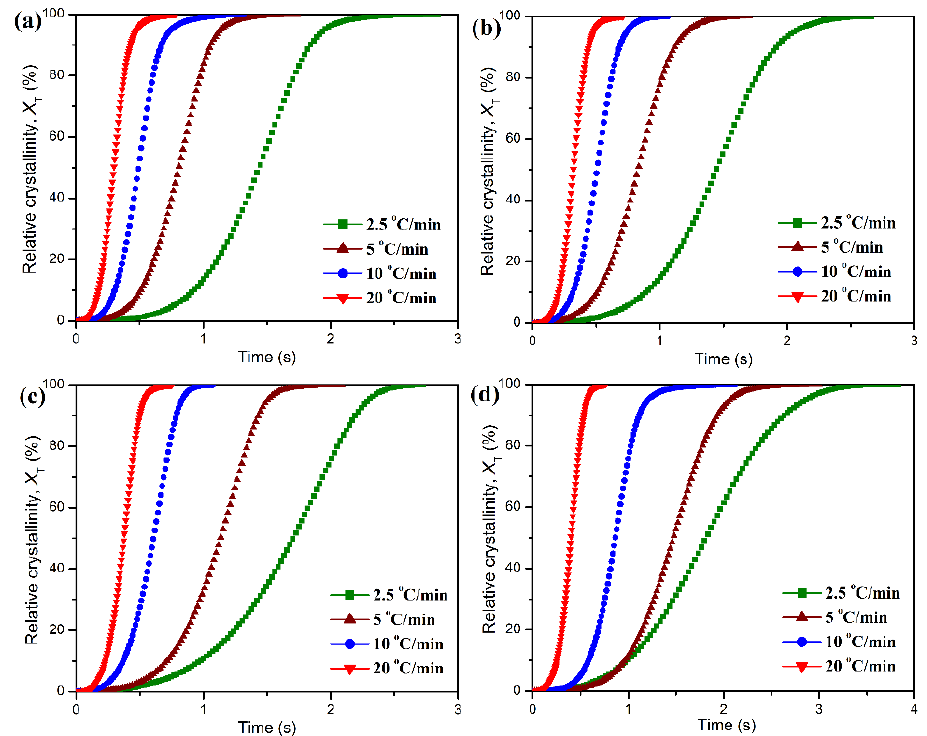
Figure 8. Development of relative degree of crystallinity as a function of time for the non-isothermal crystallization of ( a ) pure POM and its blends with ( b ) 10 wt %, ( c ) 20 wt %, and ( d ) 40 wt % of PLA at different cooling rates.